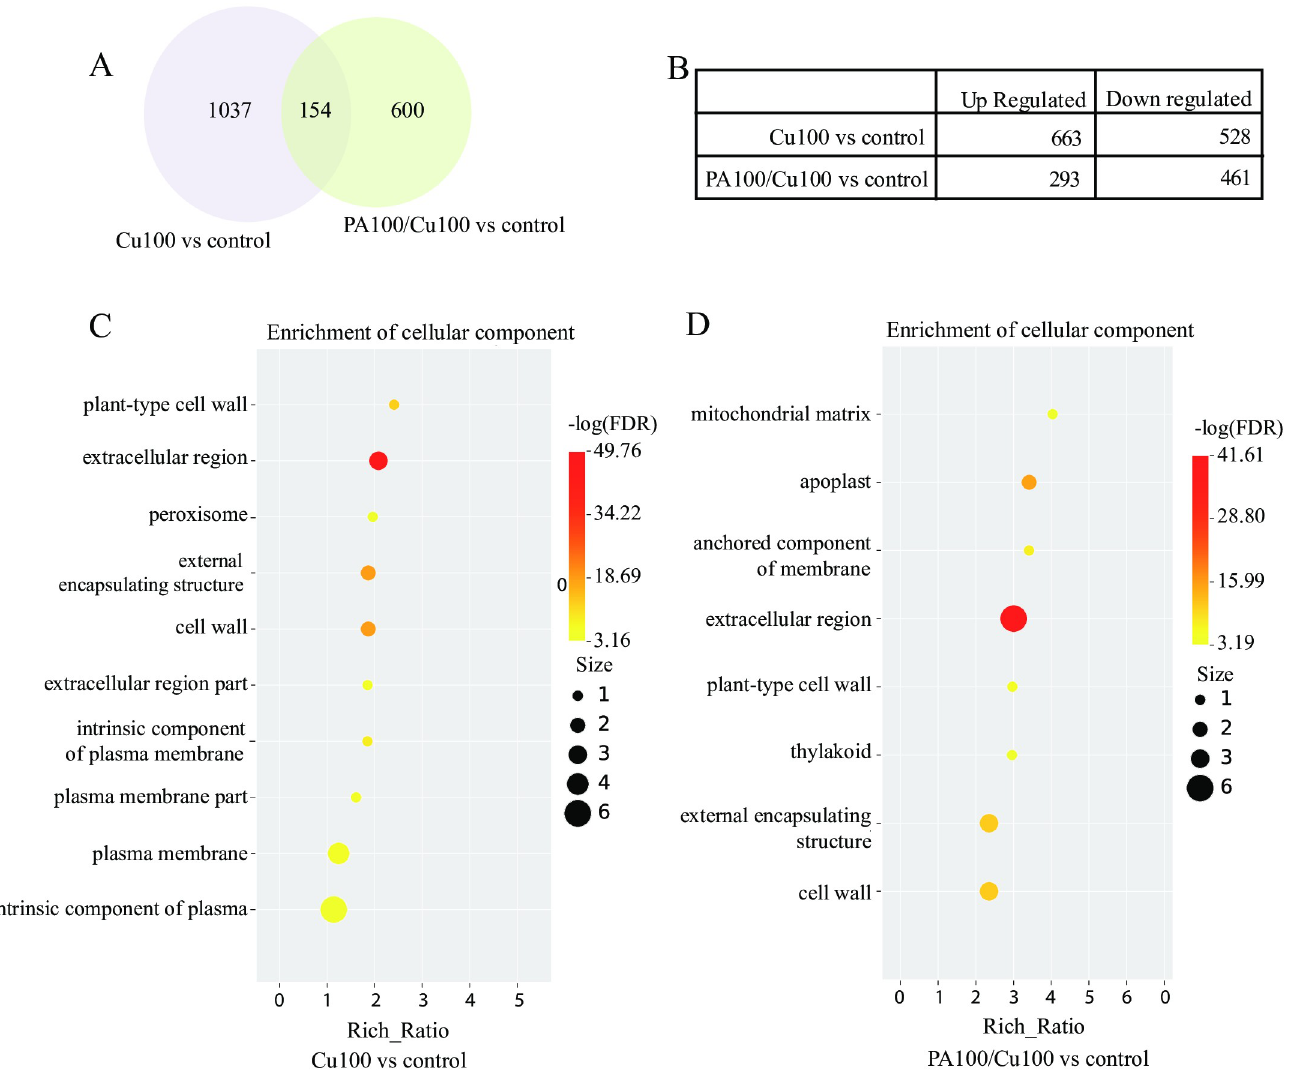
Fig 5. Analysis of differentially expressed genes (DEGs) under Cu stress. (A) Venn diagram overlap of DEGs between different comparisons. (B) Number of up- regulated and down-regulated genes in different comparisons. (C) Cellular component enrichment of DEGs under Cu stress. (D) Cellular component enrichment of DEGs under Cu stress pretreated with PAs. The bubble diagram in (C) and (D) shows the top 10 Gene Ontology items with the highest enrichment significance. The bigger bubble, higher rich-ratio, and red color indicate a higher enrichment degree. If there are fewer than 10 items, all items will be displayed. PA100: 100